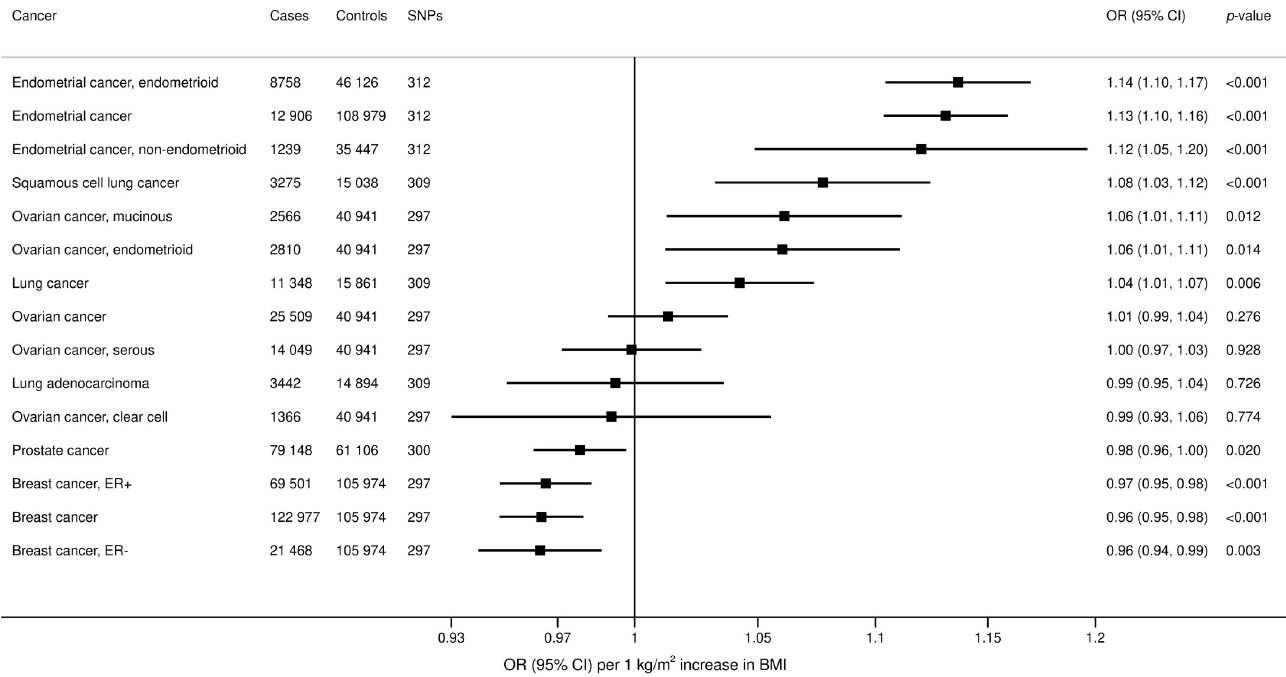
Fig 2. Associations of genetically predicted BMI with site-specific cancers in large international consortia. ORs are expressed per 1 kg/m 2 increase in BMI. Results are obtained from the random-effects inverse-variance weighted method. BMI, body mass index; CI, confidence interval; ER − , estrogen receptor negative; ER+, estrogen receptor positive; OR, odds ratio; SNP, single nucleotide